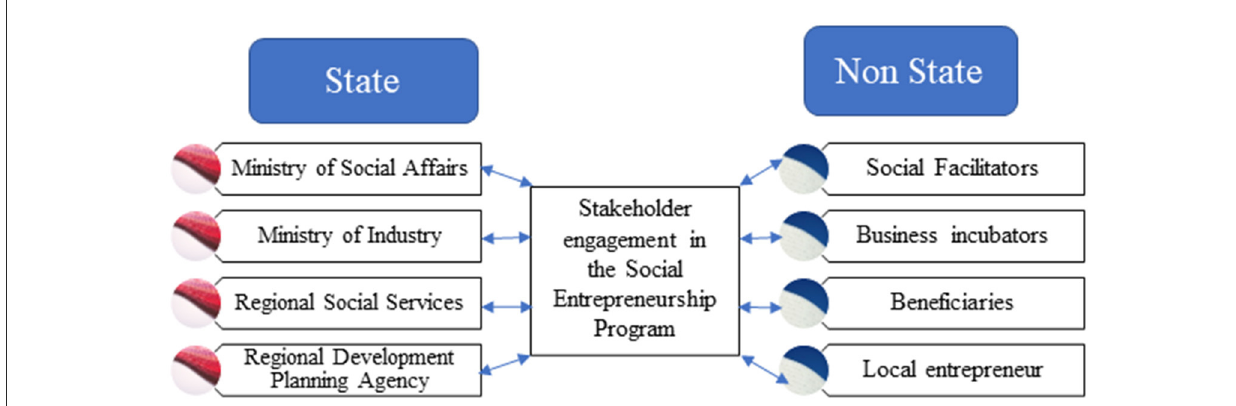
FIGURE1 Stakeholder groups in the social entrepreneurship program, namely state and non-state.